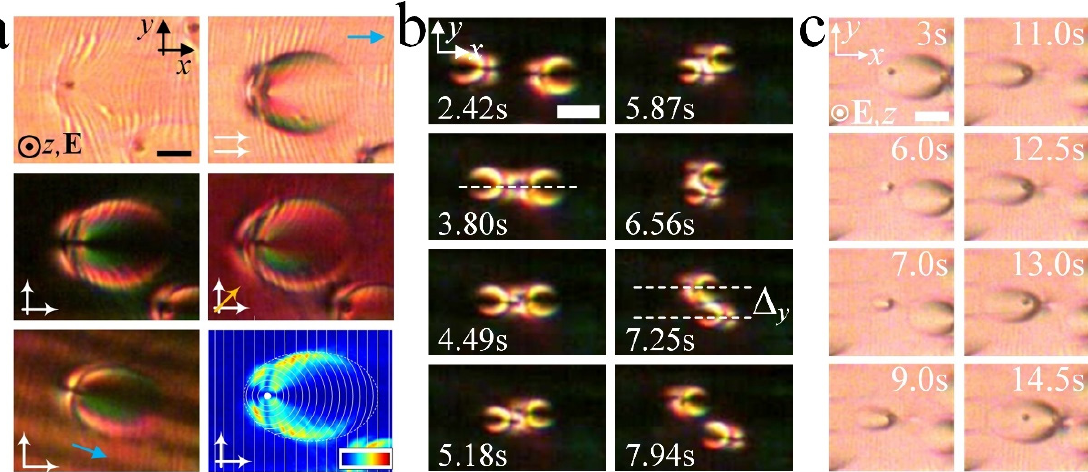
Figure 11. Swallow-tail solitons in smectics. ( a ) Polarizing micrographs of the swallow-tail soliton and its corresponding static structure. ( b ) Collision of two swallow-tail solitons. ( c ) Nucleation of swallow-tail solitons on a colloidal micro-particle. Reprinted with permission from Ref. [104]. Copyright 2021 Royal Society of Chemistry.